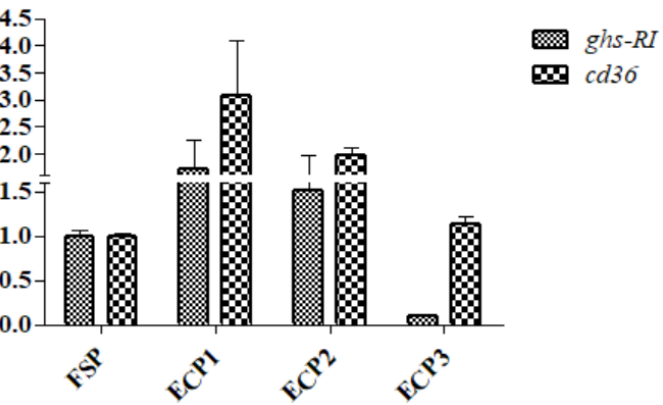
Figure 5. Effect of fish soluble pulp and enzymatic chicken pulp on the expression of ghs- RІ and cd36 on mRNA gene in the hepatopancreas of L. vannamei . ghs- RІ — Growth hormone secretagogue receptor type 1, cd36 — cluster of differentiation 36. Means without superscripts or with the same superscripts do not differ significantly ( p > 0.05), while those with different superscripts differ significantly ( p < 0.05).